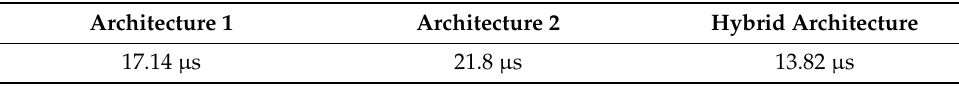
Table 5. Simulation completion time in three